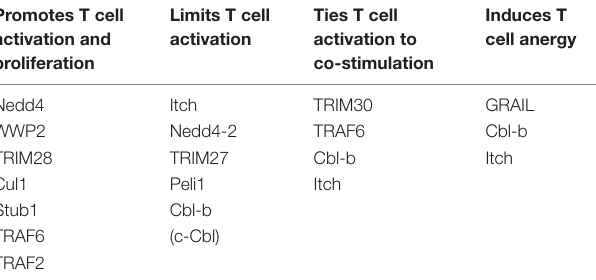
TABLe 1 | e3 ligases can promote or inhibit activation of T